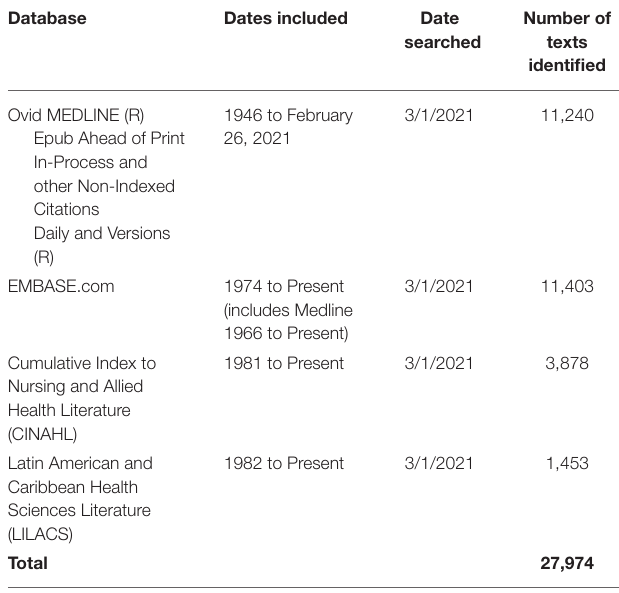
TABLE 1 | Summary of searched databases and number of texts identified by the search